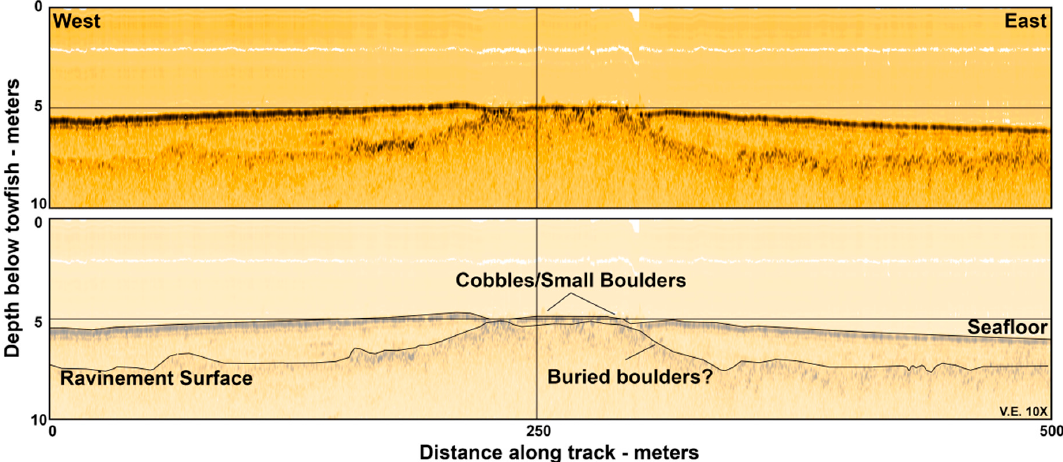
Figure 5. West to east trending seismic reflection profile from the center of the HoR extending across the (now buried) topographic high showing the seismic unit overlying the ravinement surface. Note the presence of cobbles/small boulders visible at the surface and possible buried boulders. See Figure 1 for the location of the survey line. Vertical exaggeration is 10×.